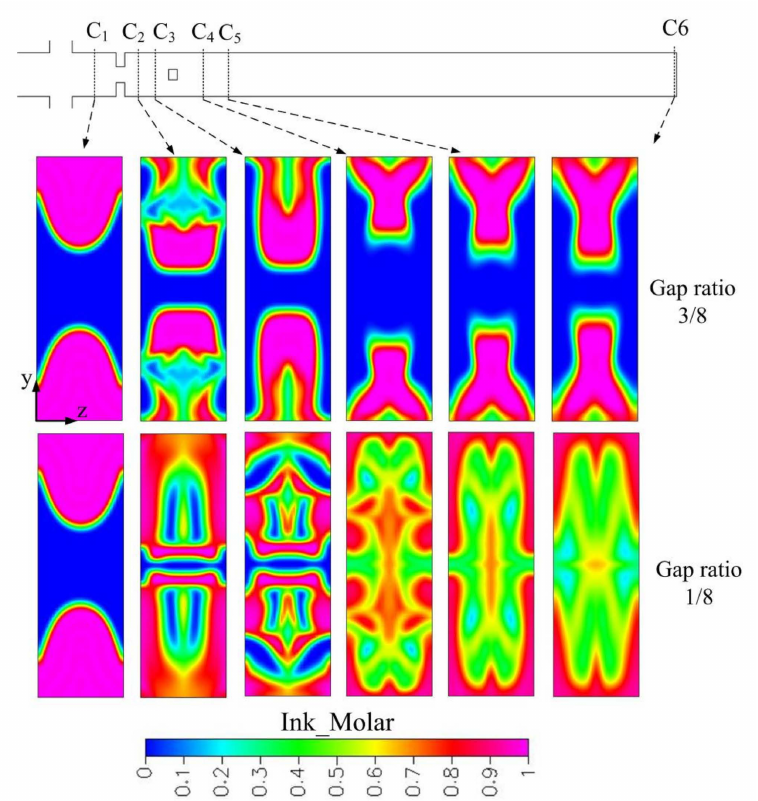
Figure 25. Cross-sectional concentration distributions of obstacled micromixer with one mixing unit at different gap ratios and Re 60 (obstacle width 80 µ m).